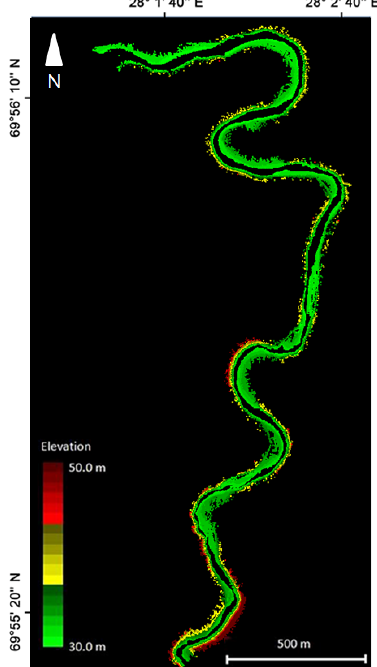
Figure 9. The river bank ground points of the BoMMS from a 4.5 km trajectory.